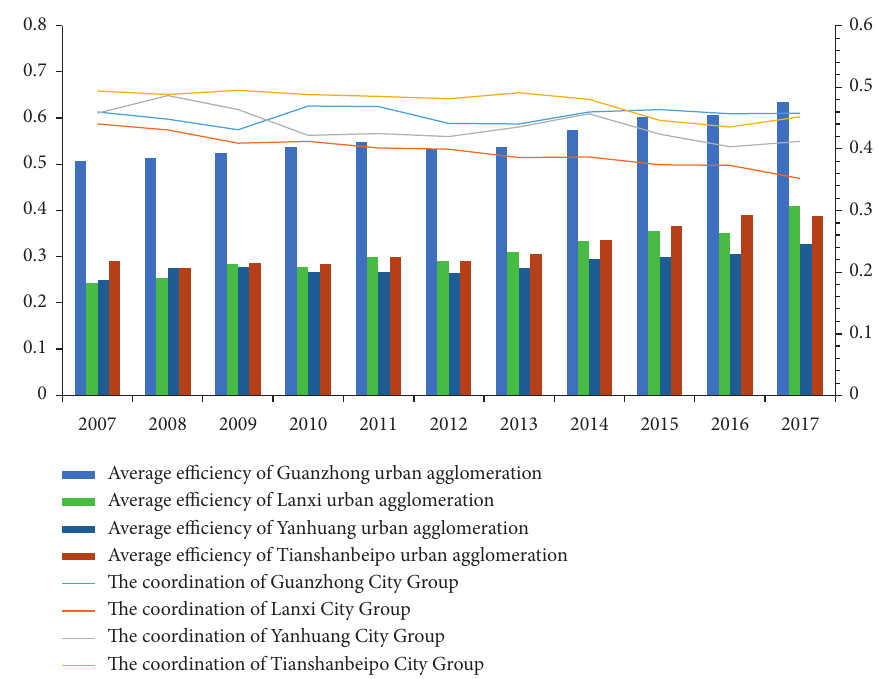
Figure 10: Efficiency and coordination of green development of urban agglomerations in Northwest China, 2007–2017. Table 4: Tobit regression